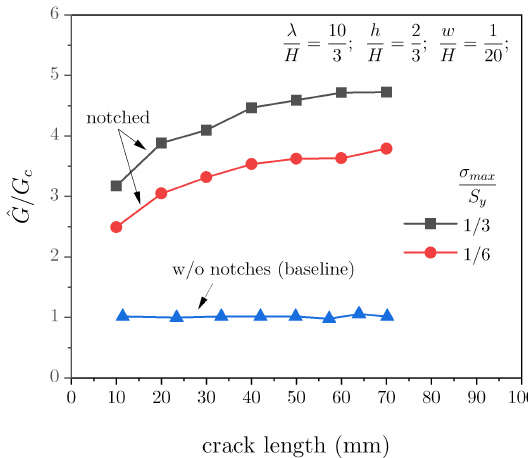
Figure 7. Apparent fracture toughness of DCB joints with notched